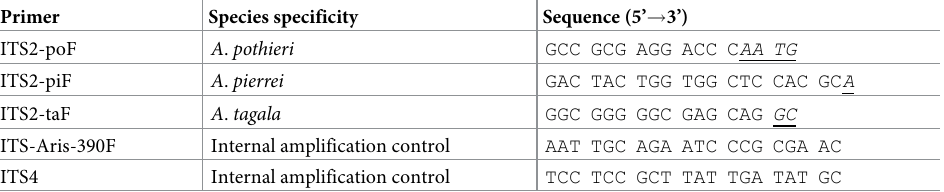
Table 3. Species-specific primers used in multiplex PCR. Underlined and italicised nucleotides represent the spe- cies-specific 3’ ends of the